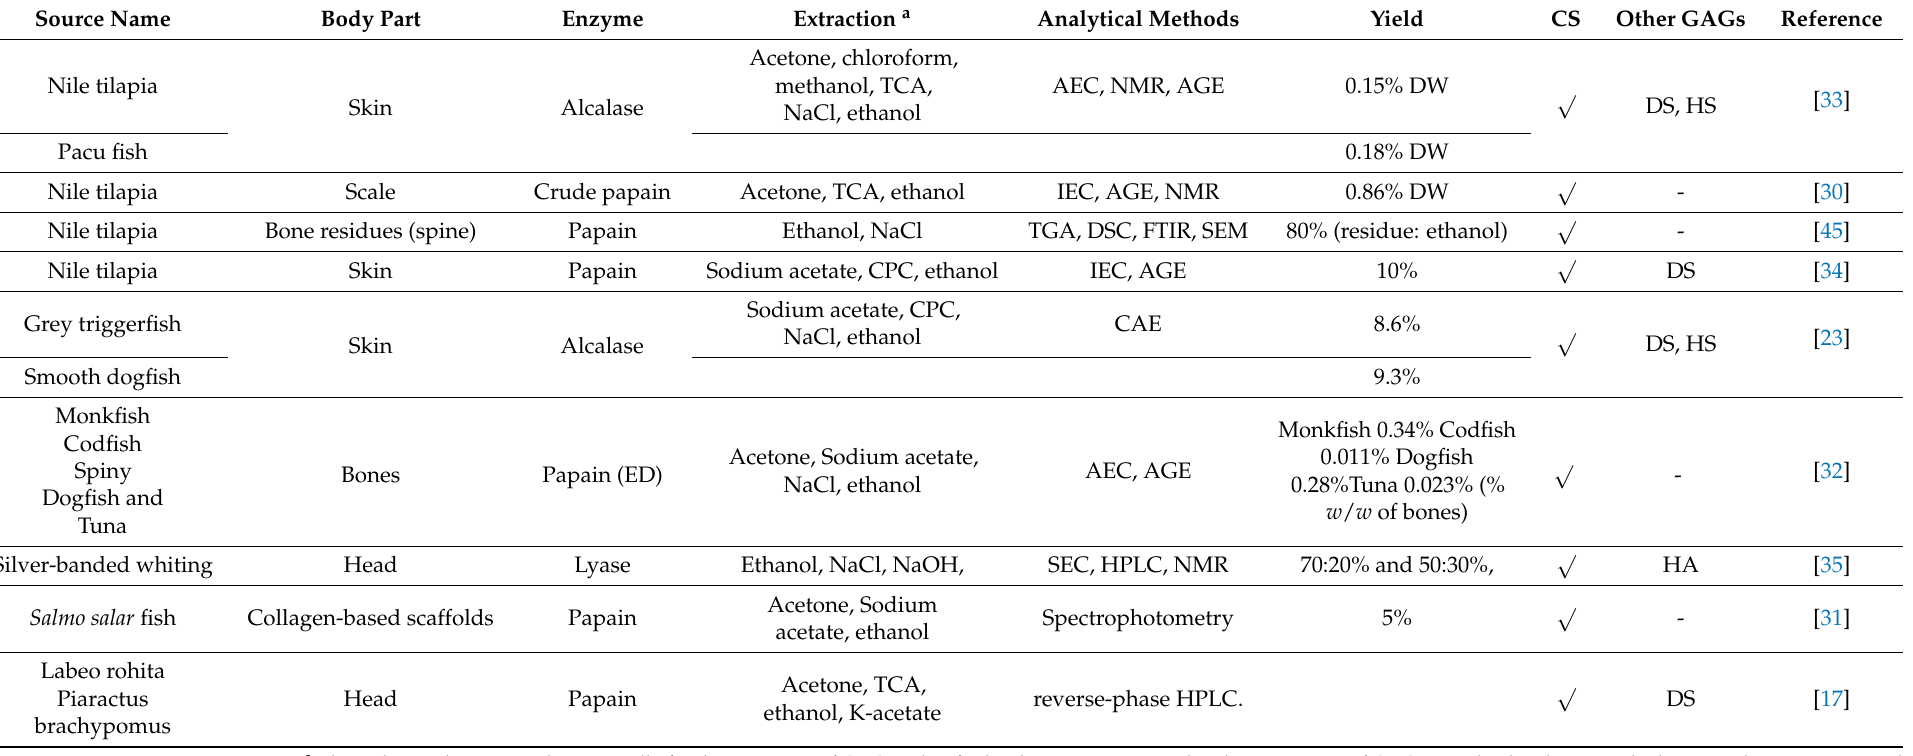
Table 2. Extraction techniques and production of chondroitin sulphate from